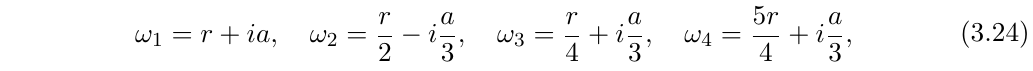
Figure 1 . Numerical results for the string tree level amplitude (cid:0) i A (0) ! 1 = ! 2 = ! 3 = != 3 (red dots), compared to the matrix model result (cid:0) i A (0) (blue dashed